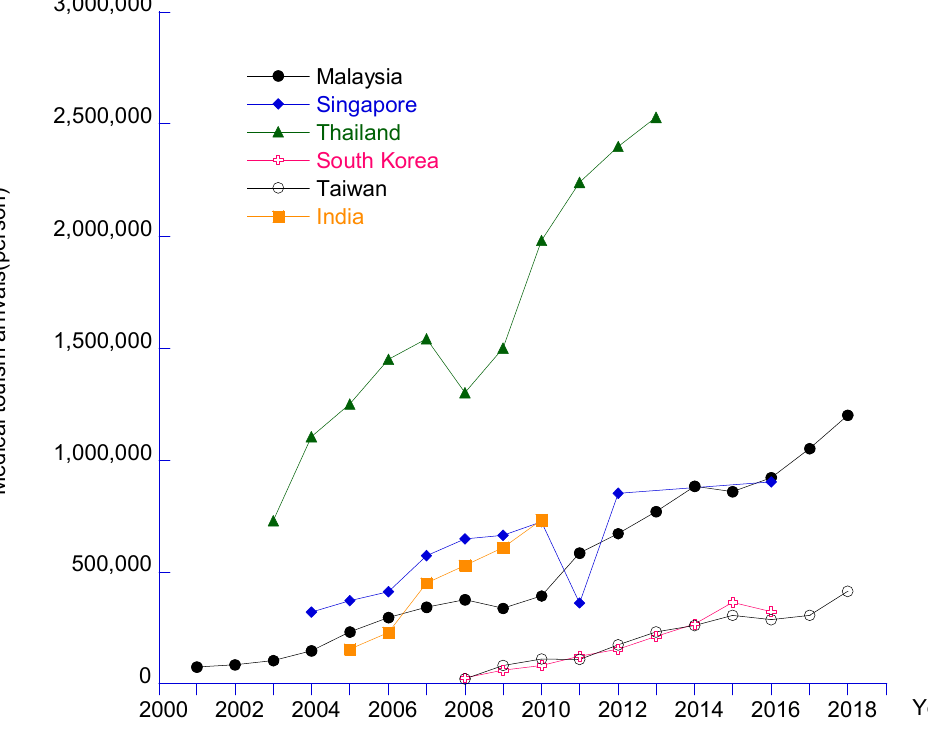
Figure 1. Trends from the medical tourism industry in the Asia-Pacific region. 1 Data collected from the following sources: [19,21,22].